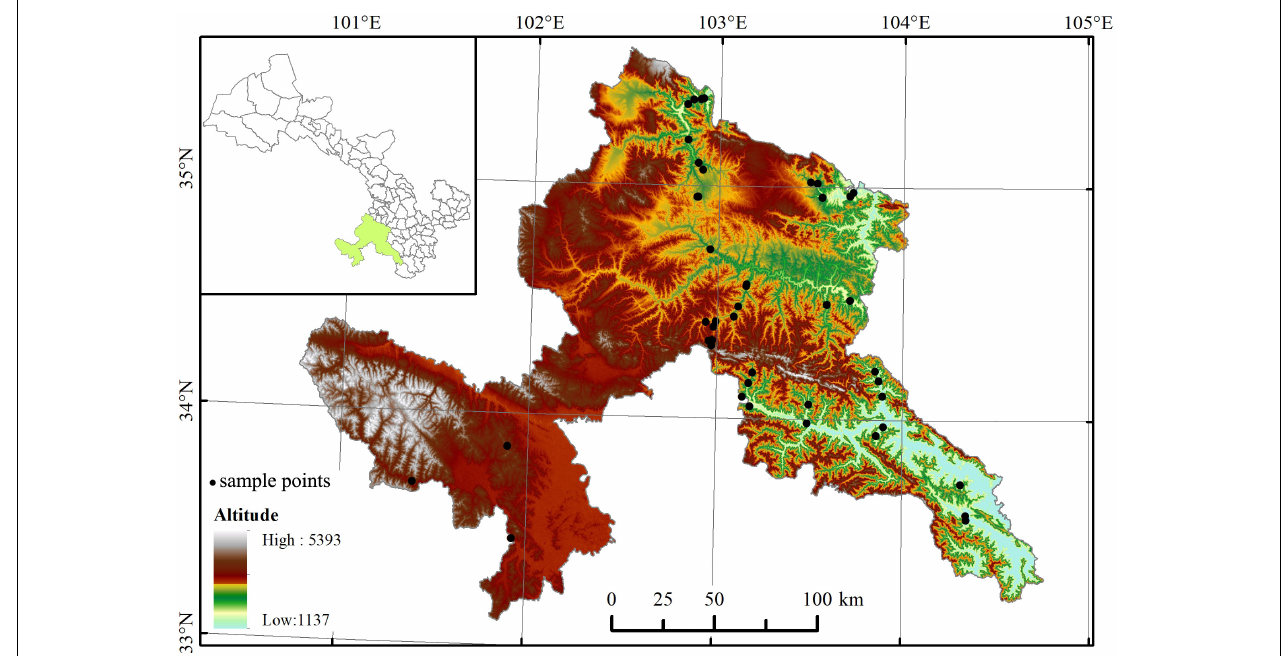
FIGURE 1 | Distribution of the 46 study sites across the eastern Qinghai-Tibetan vegetation zone. The map was edited and generated with ArcGIS 10.2 software,